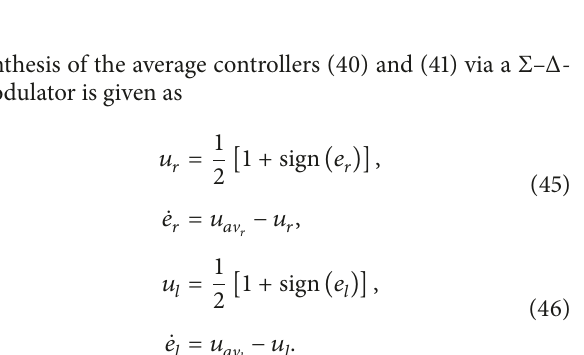
Figure 2: Block diagram of the hierarchical controller along with the